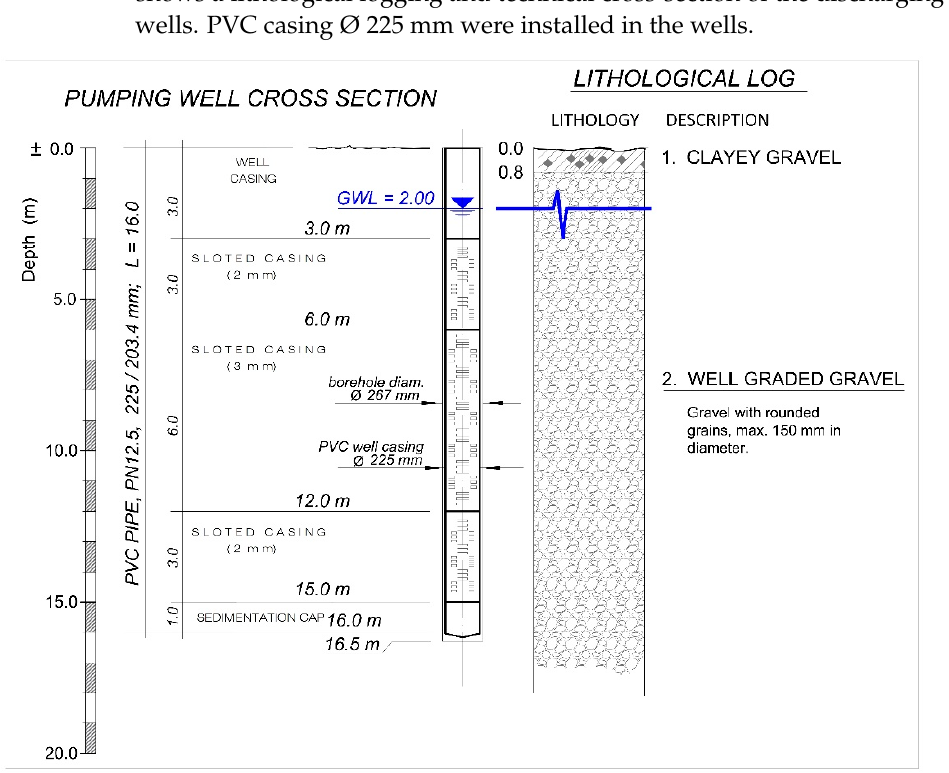
Figure 2. Lithological log and technical cross-section of the discharging and recharging